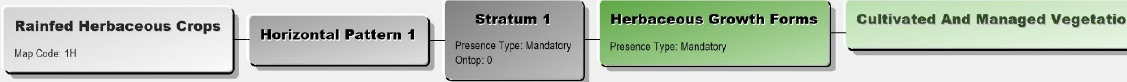
Figure 5. Rainfed herbaceous cropland class using the LCCS3 tool.